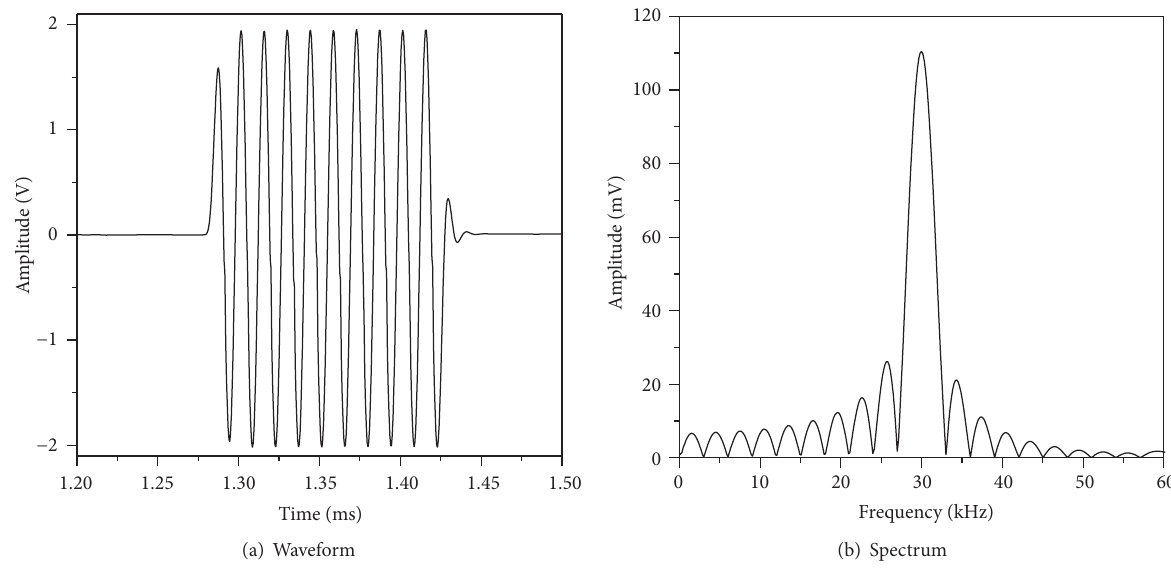
Figure 5: The waveform and spectrum for the generated ultrasonic.